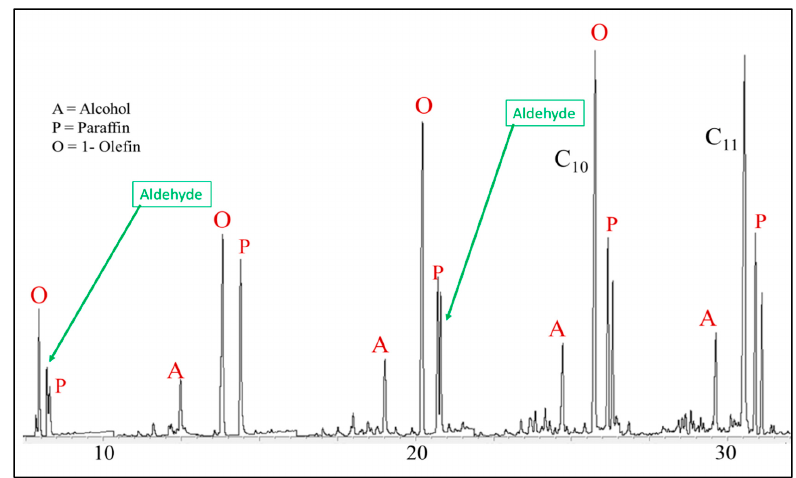
Figure 19. A chromatographic picture of a ceria support cobalt catalyst. The x-axis is retention time in minutes. Reaction Conditions: 230 °C, 27.6 bar, WHSV = 0.5, and H 2 /CO = 2.